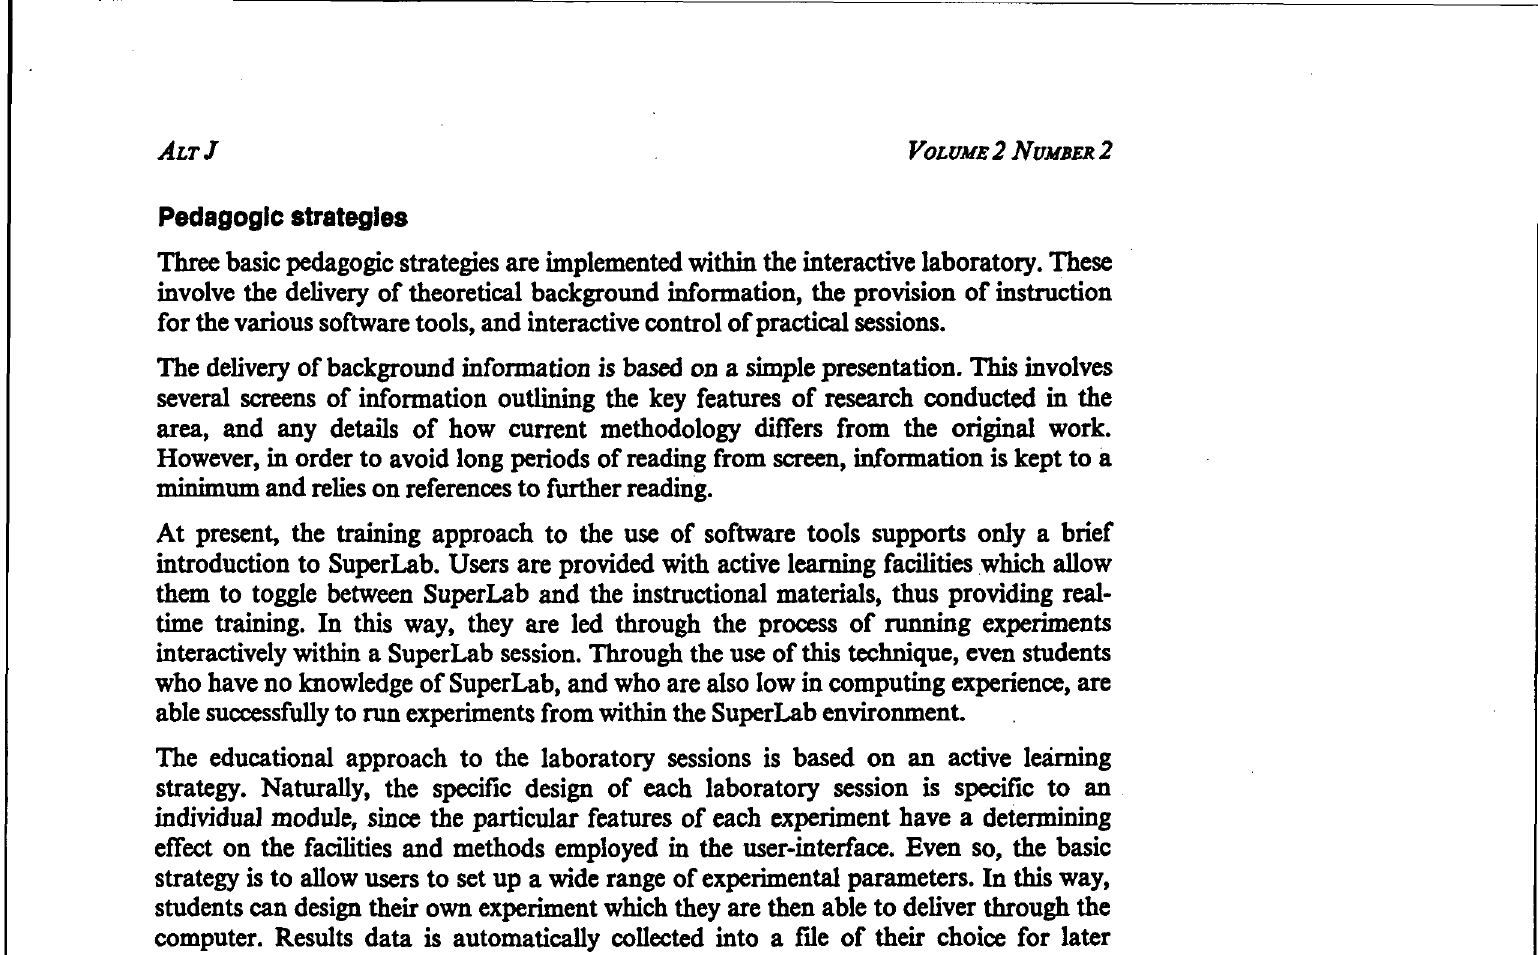
Figure 2: The graphical user-interface used